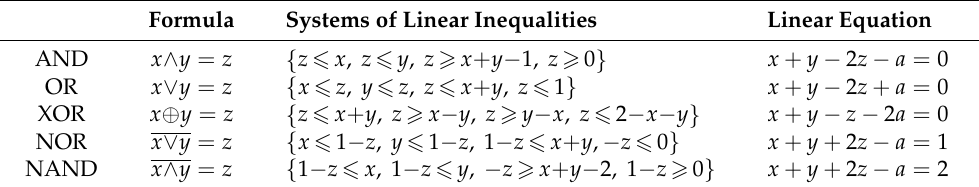
Table 1. Systems of linear inequalities and linear equations for basic Boolean functions. Formula Systems of Linear Inequalities Linear